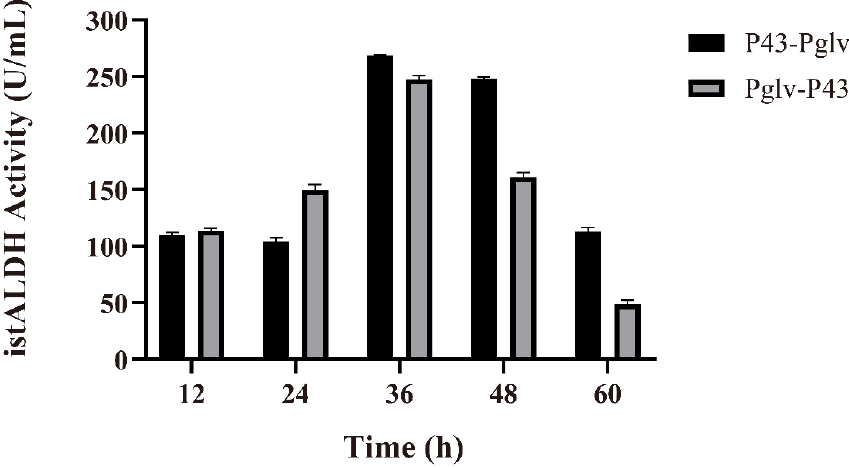
Figure 3. The istALDH activity of recombinant B. subtilis strains with tandem promoters. The experimental data were expressed as means ± standard deviations (SDs) of at least three independent experiments.